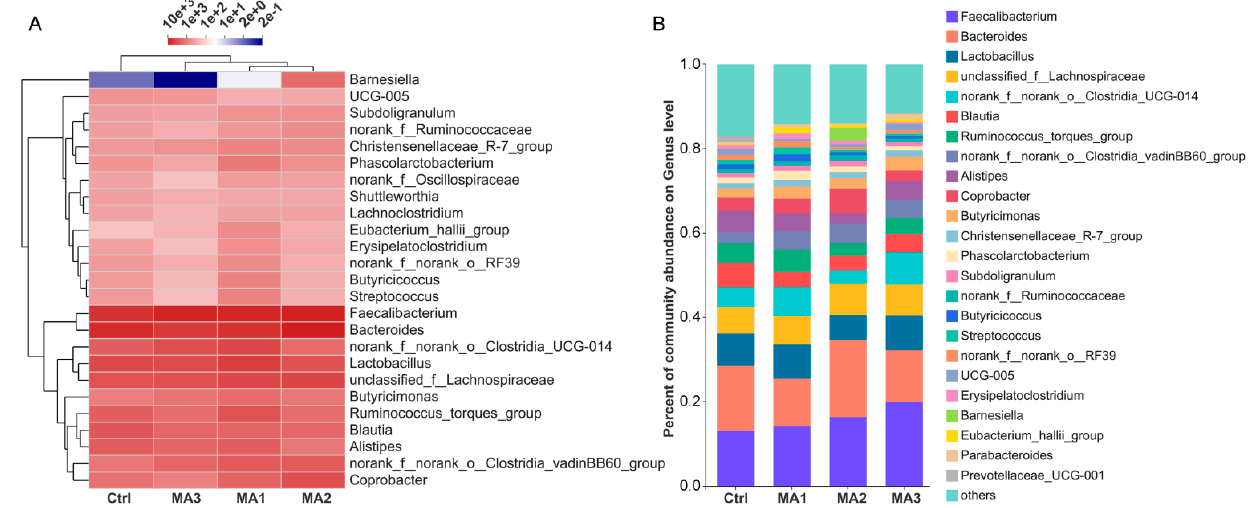
Figure 3. The microbial composition on genus level in cecum of broilers. ( A ) Hierarchical clustering of the top 25 genera based on their abundance. ( B ) The genus composition of cecal microbiota of broilers. Ctrl: the control group fed the basal diets; MA 1, 2, 3: the experimental groups fed the basal diets supplemented with 4, 8, and 12 g/kg of bio-fermented malic acid, respectively.